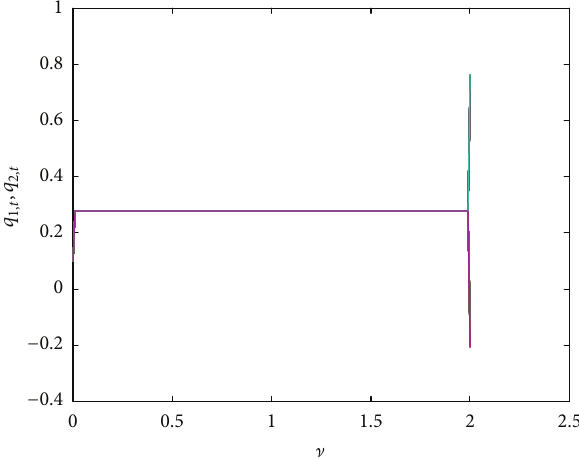
Figure 1: Behavior of 𝑞 1,𝑡 and 𝑞 2,𝑡 at the parameters: 𝑎 = 3 , 𝑐 = 2 , 𝑏 = 1 , 𝜂 = 1.7 , and ] ∈ (0, 2)